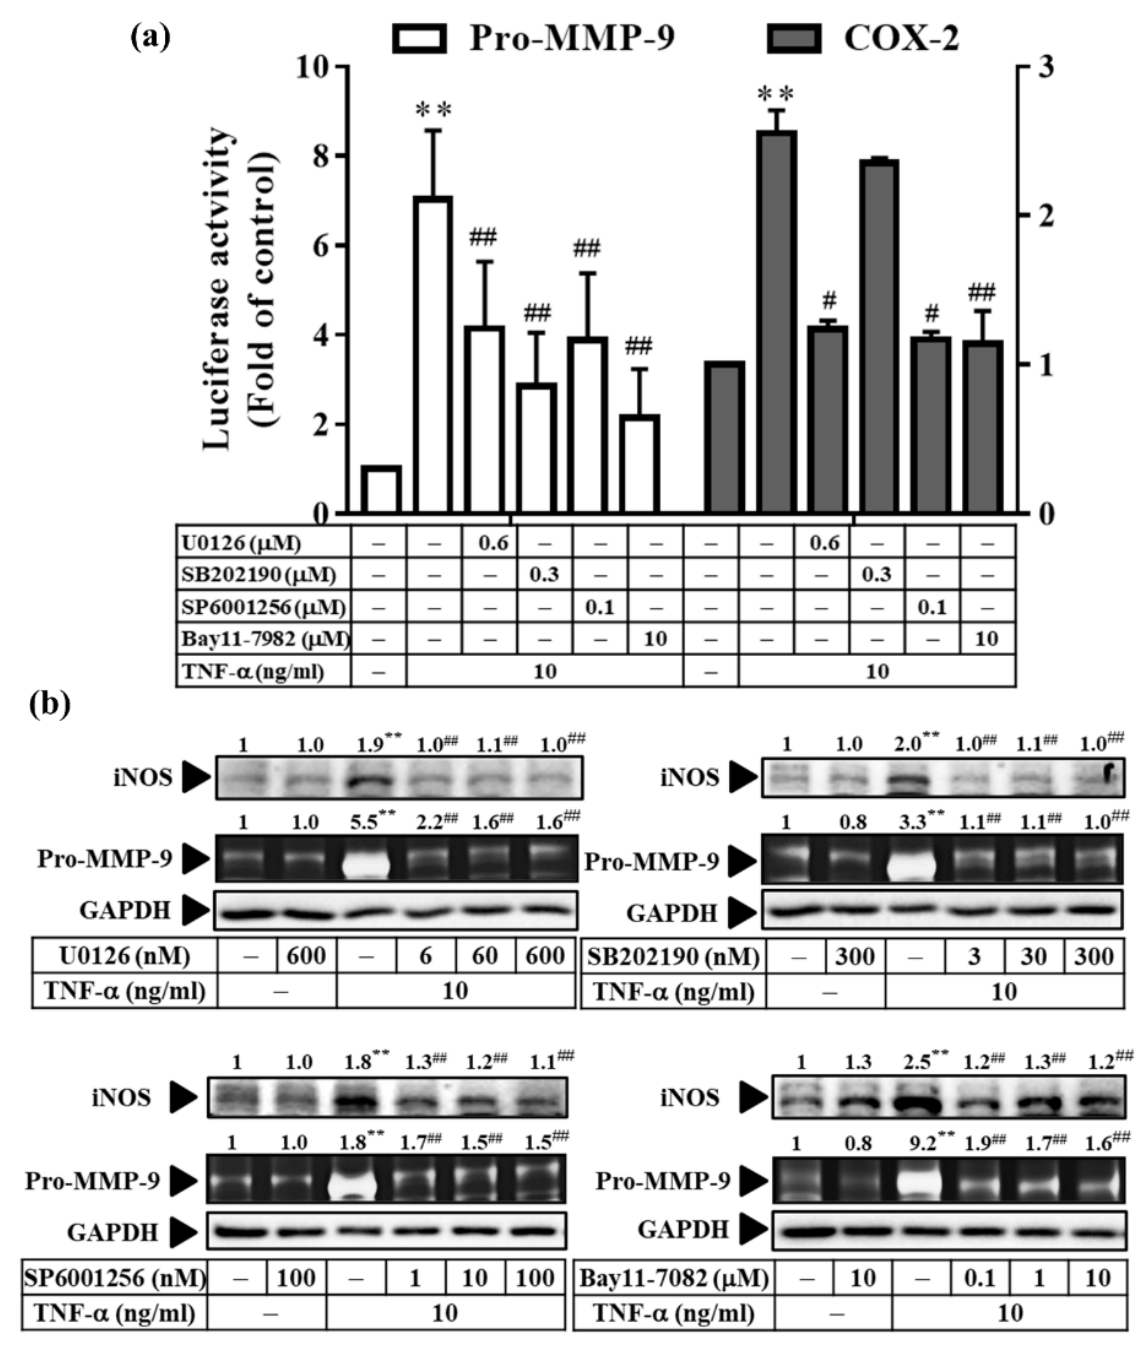
Figure 7. Involvement of MAPKs and NF- κ B in TNF- α -induced, pro-MMP-9 expression. Cells